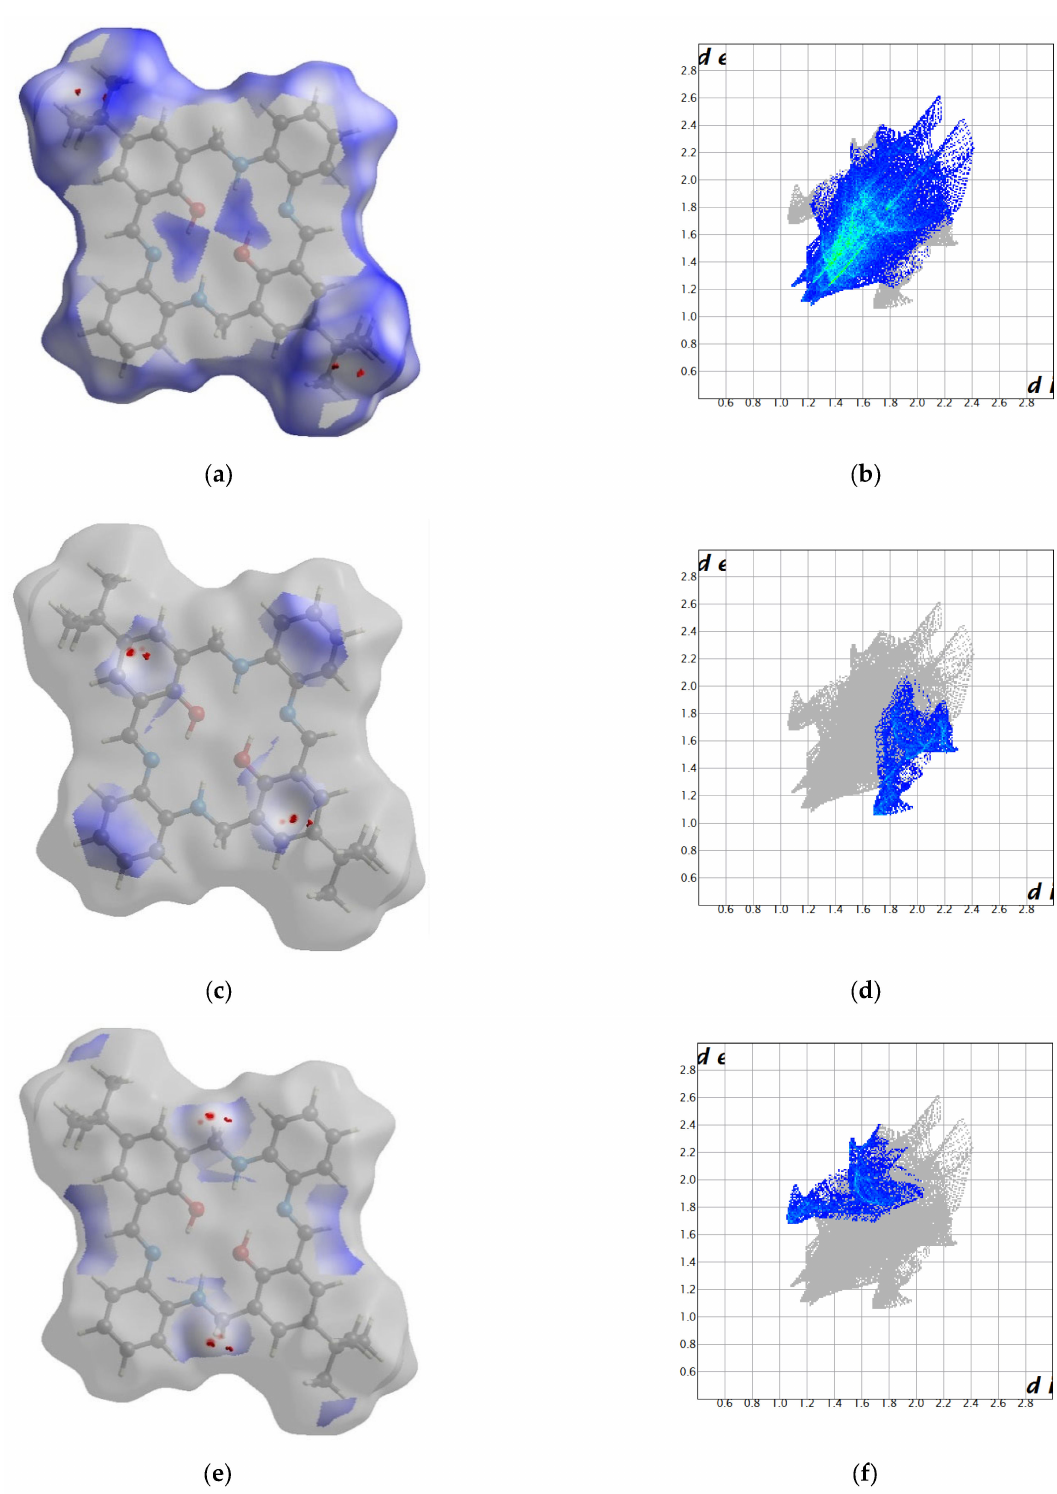
Figure 5. Hirshfeld surfaces and fingerprints of selected interactions created in the crystal network of L2 : ( a ) Hirshfeld surface for H . . . H (red markers correspond to the spike at 1.15, 1.1); ( b ) fingerprint for H . . . H (65.4%); ( c ) Hirshfeld surface for C . . . H (red markers correspond to the spike at 1.7, 1.1); ( d ) fingerprint for C . . . H (12.4%); ( e ) Hirshfeld surface for H . . . C (red markers correspond to the spike at 1.1, 1.7); ( f ) fingerprint for H . . . C (10.6%) for O14 molecule In brackets, there is given surface area included as a percentage of the total surface